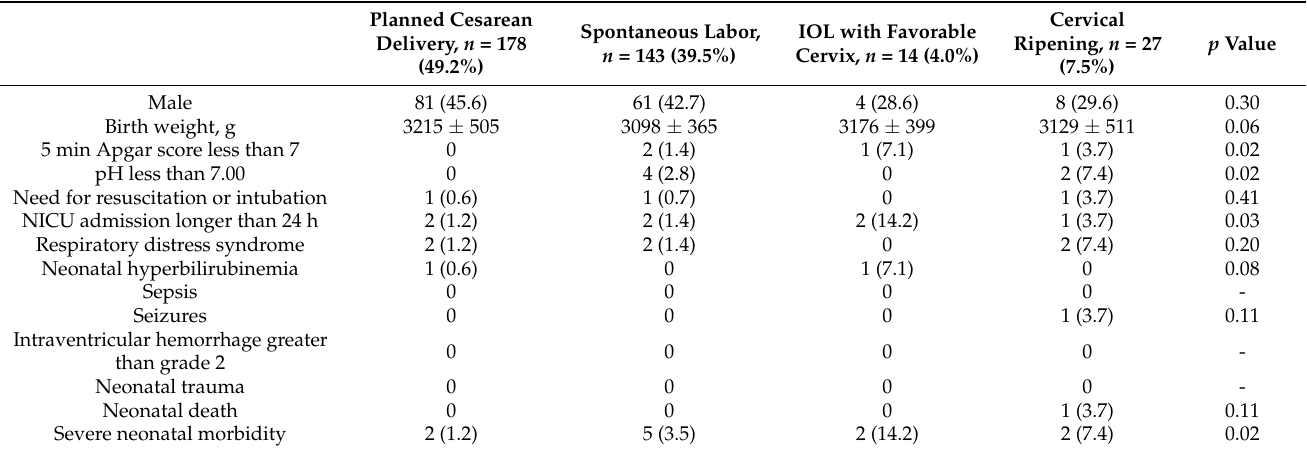
Table 3. Neonatal outcomes according to the type of